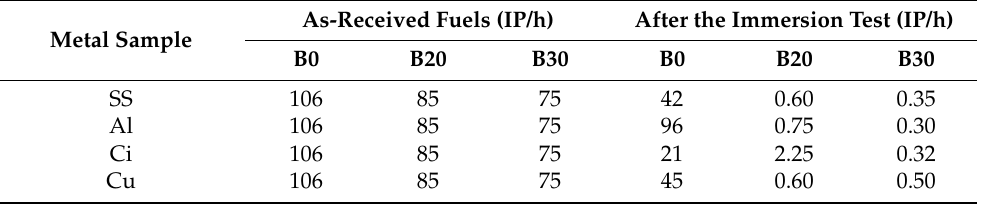
Table 3. Oxidation stability (induction period, h) of the fuel samples after the immersion